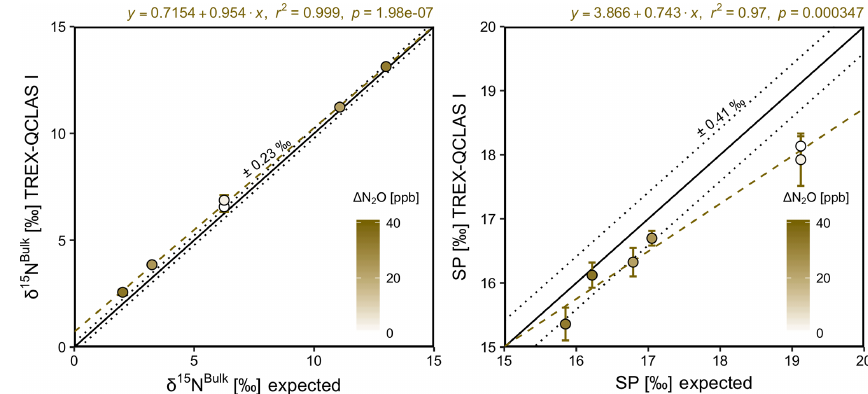
Figure 13. Correlation diagrams for δ 15 N bulk and SP measurements at various (cid:49) N 2 O mole fractions analyzed by OA-ICOS I plotted against expected values. The remaining plots for [ N 2 O ] , δ 15 N α , δ 15 N β and δ 18 O are provided in Sect. S4 (Fig. S4-14). The solid black line denotes the 1 : 1 line, while the dotted line indicates ± 1 σ of the residuals from the 1 : 1 line. The dashed green line represents a linear fit to the data. Individual equations, coefficients of determination ( r 2 ) and p values are indicated above each plot. Each data point represents the mean and standard deviation (1 σ ) of triplicate measurements. The inset plots indicate the standard deviation (1 σ ) of the triplicate measurements achieved at different (cid:49) N 2 O mole fractions, and the 1 : 1 line is similarly a solid